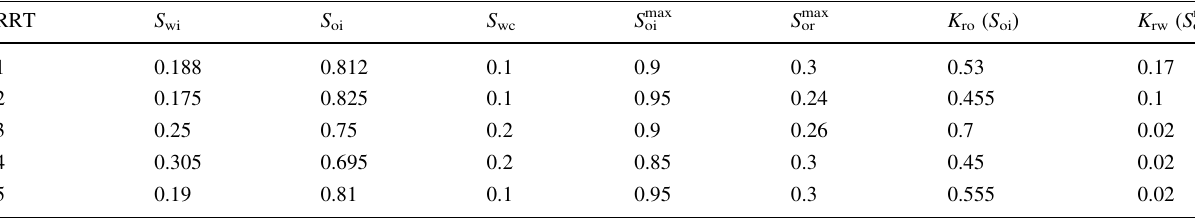
Fig. 19 Drainage and imbibition K r correlation for sample plug #139 Table 7 End point parameters of permeability and saturation for RRTs